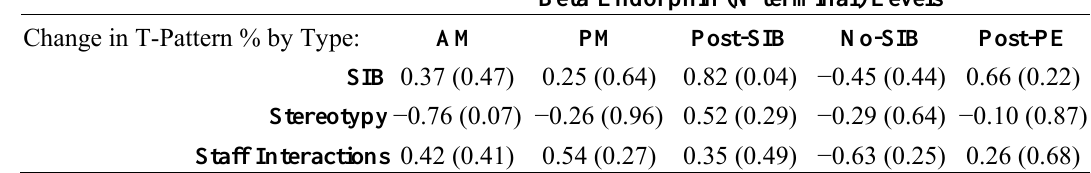
Table 1. Pearson’s r coefficients (significance) between levels of beta-endorphin (N- terminal) collected in either the AM, PM, or following SIB, no SIB, or physical exercise (PE) and the change in the percentages of T-patterns (by behavior type) for weeks treated with placebo and